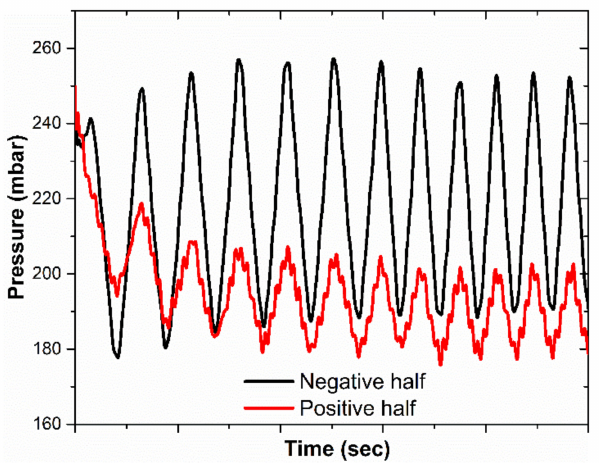
Figure 17. Pressure drop at negative and positive half-cell during the operation of a